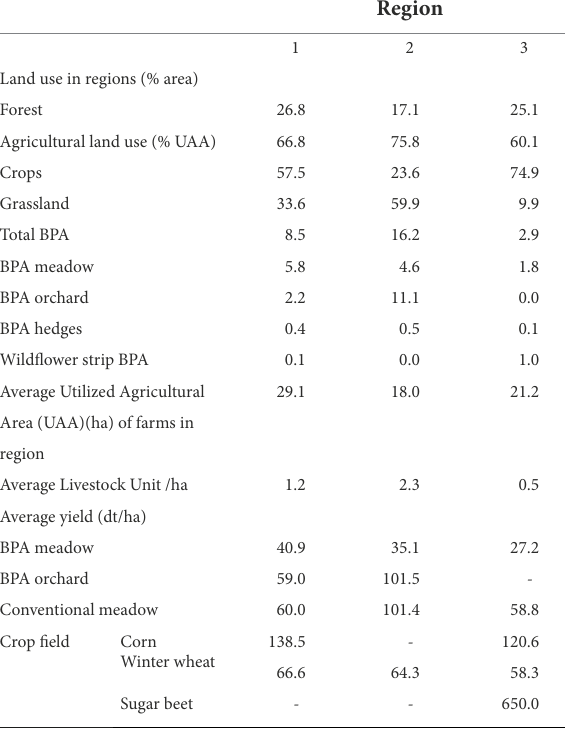
TABLE 4 Major land use categories, agricultural characteristics of BPA, and production fields in the 3